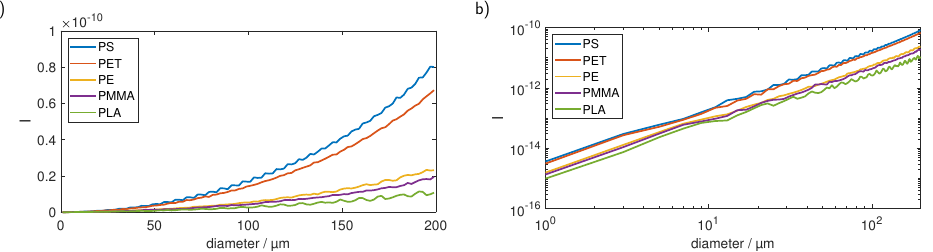
Figure 10. Calibration for five typical microplastic materials in ( a ) linear and ( b ) double logarith- mic plots. The signal course is comparable between all materials; however, the absolute values differ largely.